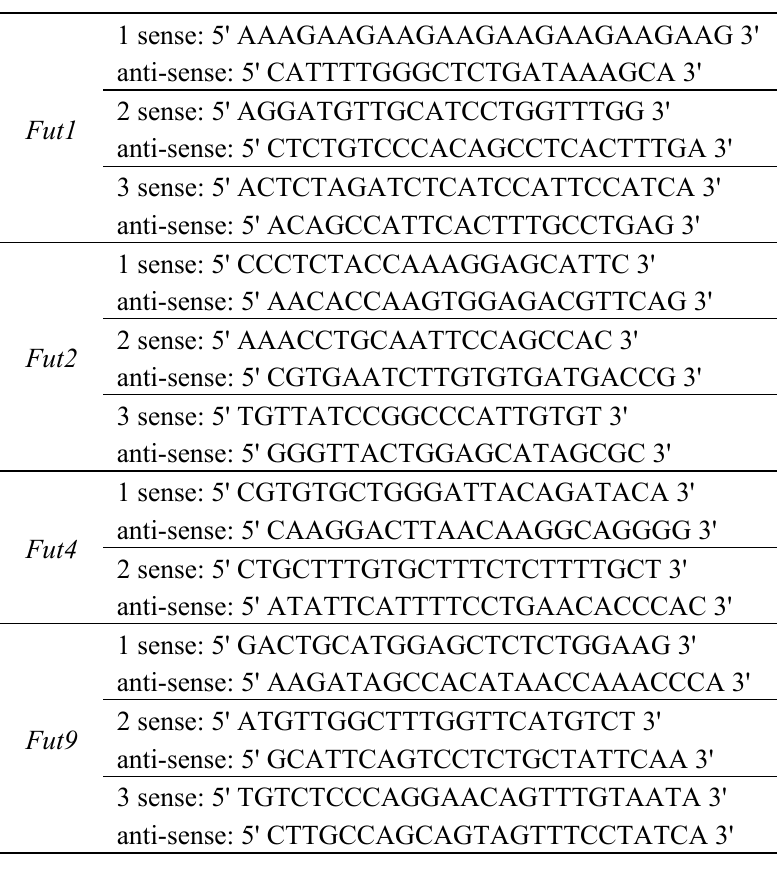
Table 2. Primers for ChIP-PCR.